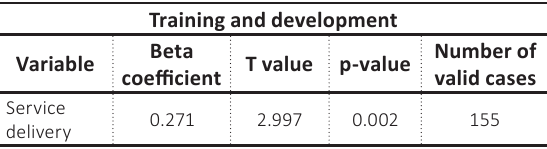
Table 6. Association between training and development and service